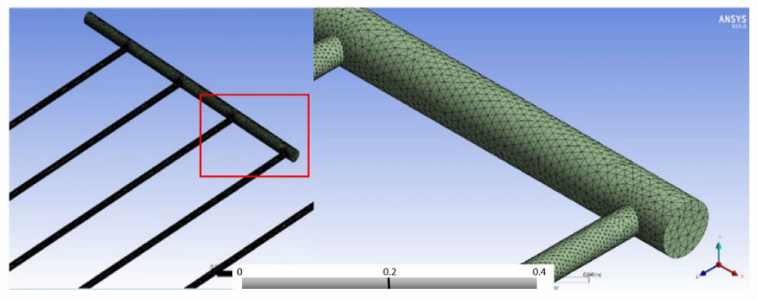
Figure 12. Mesh of the solar thermal collector